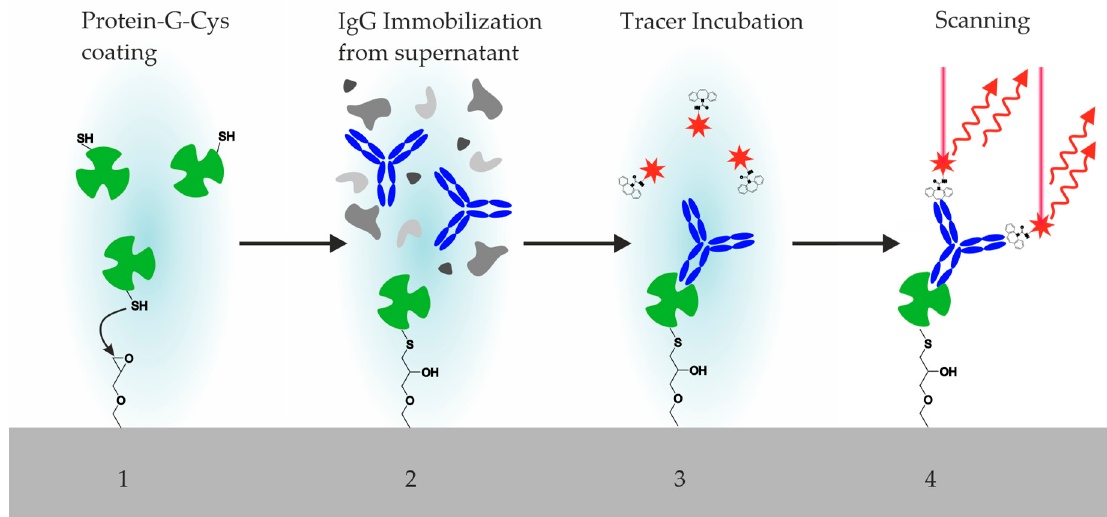
Figure 6. Incubation steps of the hybridoma screening process: 1. Printing and incubation of an epoxy-silanized glass chip with a Cys-Protein-G solution. Washing step. 2. Printing and incubation of hybridoma supernatant. Washing step. 3. Incubation of fluorescence tracer (labeled antigen or